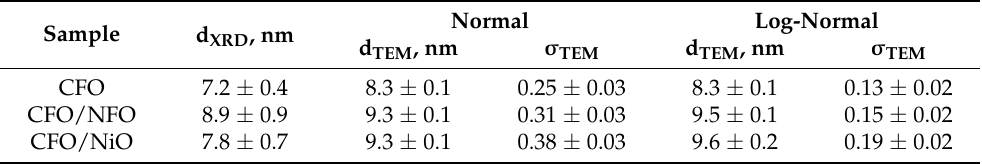
Error for d XRD is the standard deviation over values for all peaks; the error for d TEM and σ TEM is the error of fitting with normal and log-normal